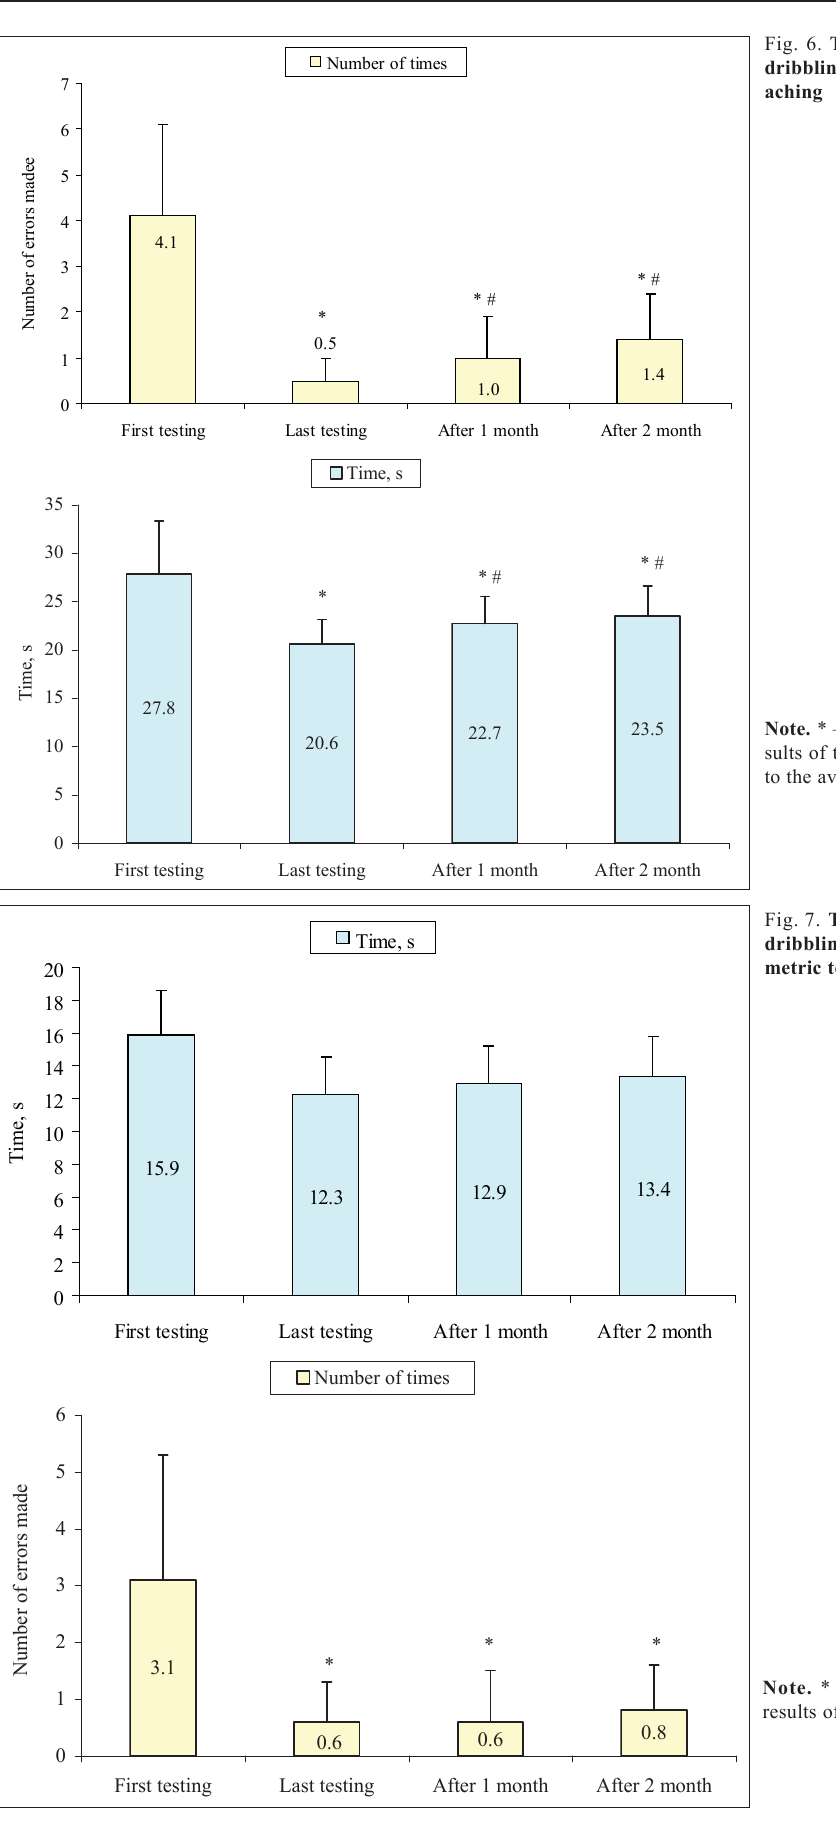
Fig. 6. The indices of stability of mastering dribbling a ball in the group of standard te- aching